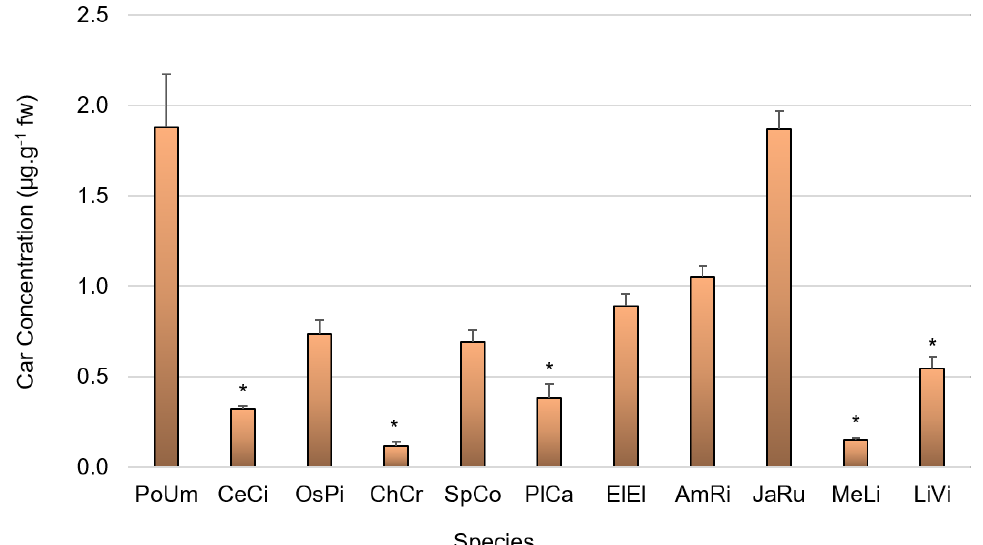
Figure 7. Carotenoid concentration of the eleven studied red seaweed species expressed in µg.g −1 fresh weight. PoUm: Porphyra umbilicalis , CeCi: Ceramium ciliatum , OsPi: Osmundea pinnatifida , ChCr: Chondrus crispus , SpCo: Sphaerococcus coronopifolius , PlCa: Plocamium cartilagineum , ElEl: Elisolandia elongata , AmRi: Amphiroa rigida , JaRu: Jania rubens , MeLi: Mesophyllum lichenoides , LiVi: Liagora viscida . Values are presented as means ± SD ( n = 3), and asterisks (*) indicate statistically significant differences between the species with the highest carotenoid content (PoUm) and all other remaining species (Kruskal – Wallis test ( χ 2 (10) = 31.451; p = 0.000)).